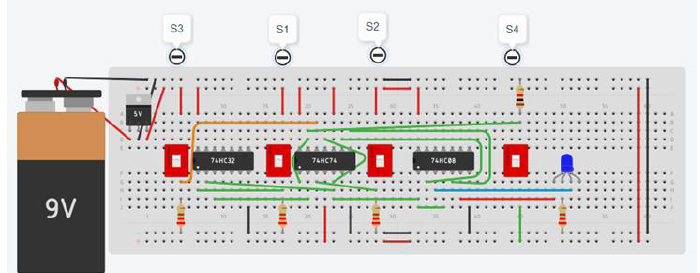
Figure 3. Block circuit (Tinkercad).